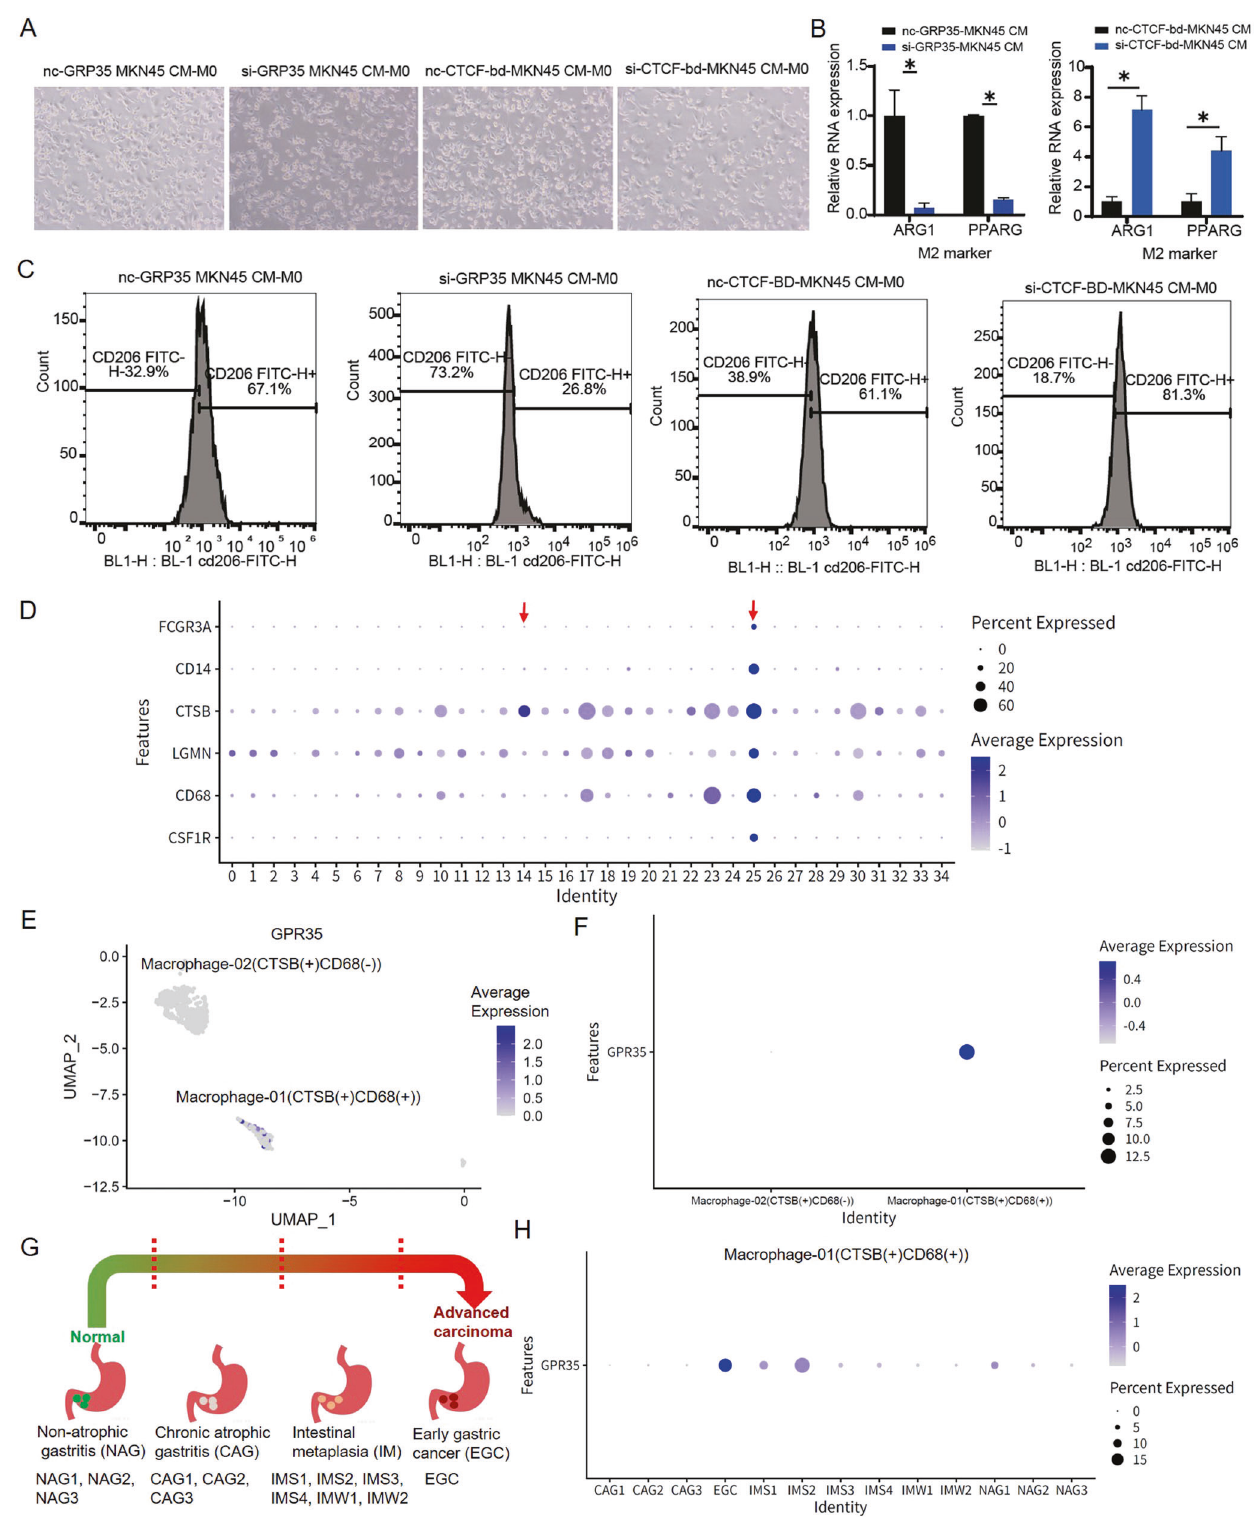
Fig. 7 GPR35 functions in M2 polarization and gastric cancer development. A The representative images of M0 macrophages morphological change (from oval cells to antennal, spindle-shaped adherent cells) for different treated groups, i.e., si-GPR35, si-CTCF-bd of CAPN10, and negative control. B Quantitative data of M2 markers in different treated groups. C Relative positive rate for CD206 in different treated groups. D – H GPR35 levels in different cluster macrophages in gastric premalignant lesions and early gastric cancer. D Average expression for biomarkers of macrophage in clusters for cells of various gastric disease tissues. E – F UMAP ( E ) and bubble ( F ) diagram for GPR35 expression level in macrophage-01/02. G Sample composition for scRNA-seq. H GPR35 expression level for CTSB + and CD68 + macrophage in various